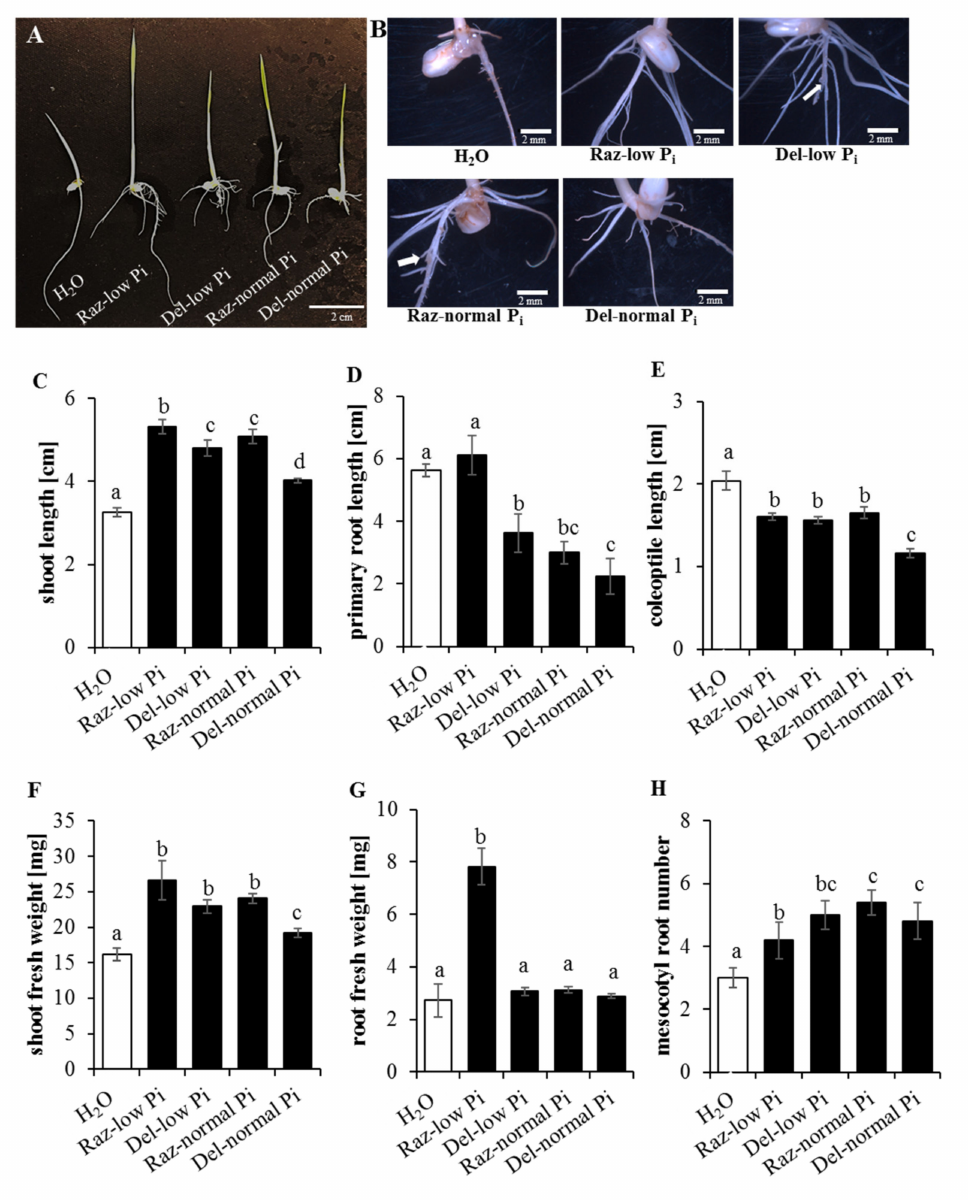
Figure 6. Effect of sorghum ash fertilisation on rice seedling growth. ( A ) Seedlings of Nihonmasari rice variety that have been raised for 8 d in five different hydroponic growth media: (1) H 2 O; (2) 0.5 g of Razinieh’s straw ash grown in P i -poor soil up to maturity dissolved in 100 mL of H 2 O,